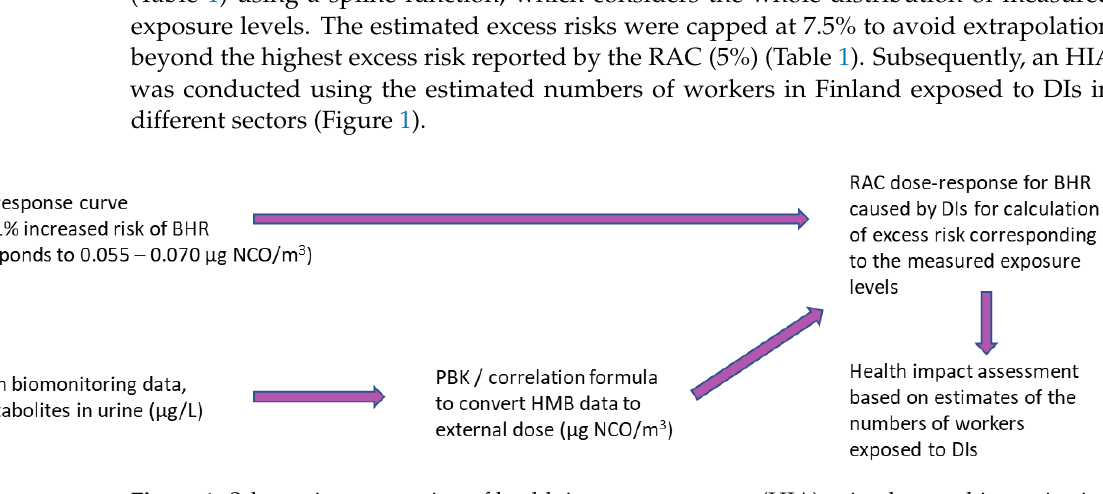
Figure 1. Schematic presentation of health impact assessment (HIA) using human biomonitoring (HMB) data to convert urine diisocyanate (DI) metabolite concentration to external isocyanate (NCO) exposure using a physiological based kinetic (PBK) model and a correlation formula. The dose–response curve for DI-caused bronchial hypersensitiveness (BHR) was used in HIA and provided by RAC [5]. Table 1. Excess risk over working life period of bronchial hyperresponsiveness or diisocyanate asthma [5]. Excess Risk Over Working Life Period